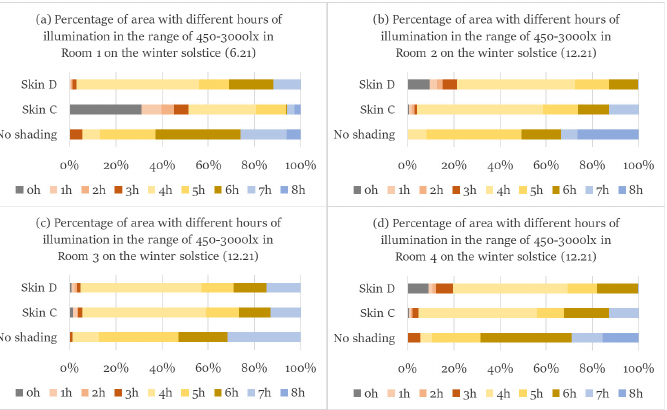
Figure 18. Percentage of the area with different hours of illumination in the range of 450–3000l× in ( a ) Room 1, ( b ) Room 2, ( c ) Room 3, and ( d ) Room 4 on the winter solstice (12.21) (self-developed).